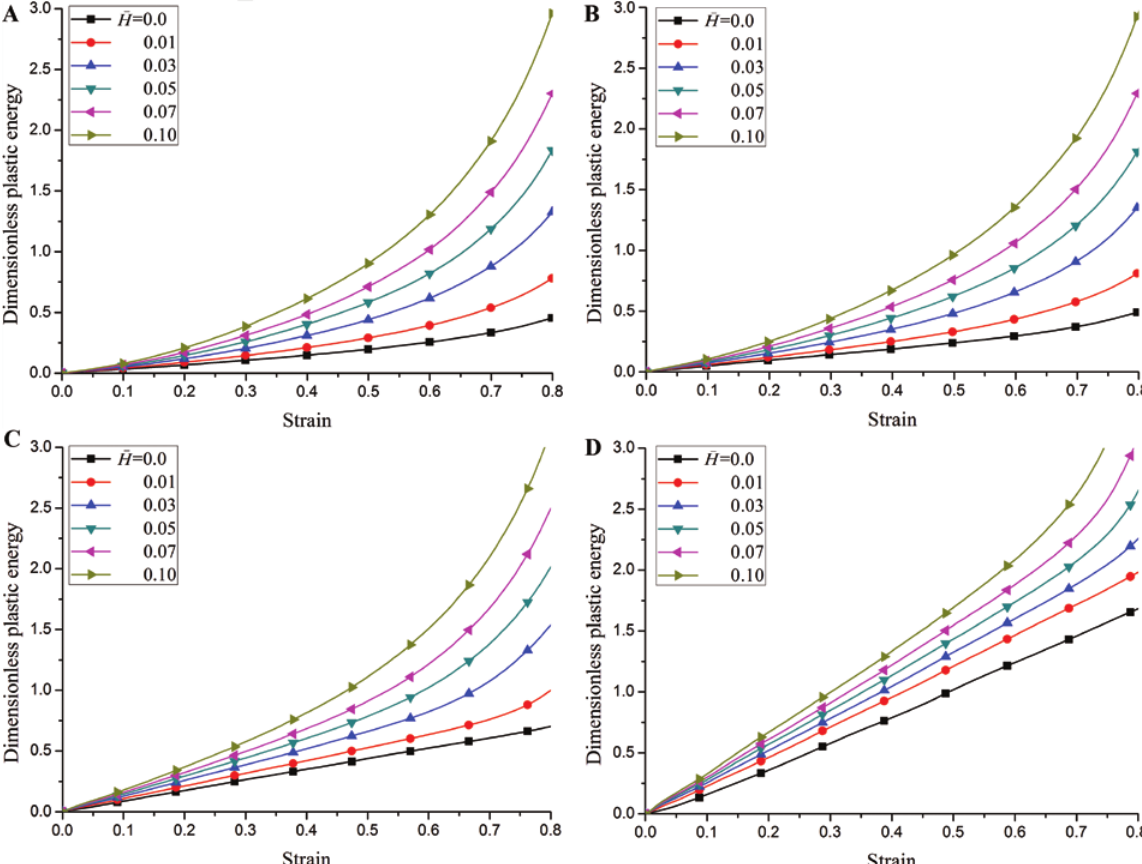
Figure 11: Dimensionless plastic energy dissipation at different velocities (A, 10 m/s; B, 50 m/s; C, 120 m/s; D, 250 m/s).